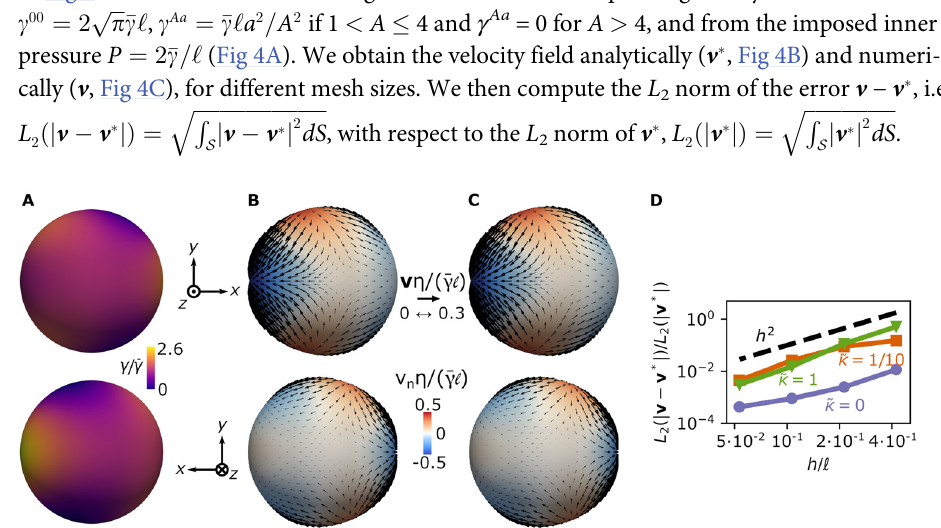
Fig 4. Single cell dynamics and convergence of the numerical framework. (A) An inhomogeneous pattern of active surface tension γ is imposed on a spherical surface. (B) Analytically computed velocity field generated by the active tension profile in A. The velocity field is decomposed into its normal (colormap) and tangential (arrows) components. (C) Numerical solution for the velocity profile generated by the active tension profile in A. (D) Discretisation error, evaluated here in terms of the L 2 norm of the difference between the analytical and numerical solutions for the velocity, as a function of the average mesh size h and for ~ k ¼ k = ð � g ‘ 2 Þ ¼ 0 (blue), ~ k ¼ 0 : 1 (orange) and ~ k ¼ 1 (green). Other parameters are ξℓ 2 / η = 4, C 0 ℓ =